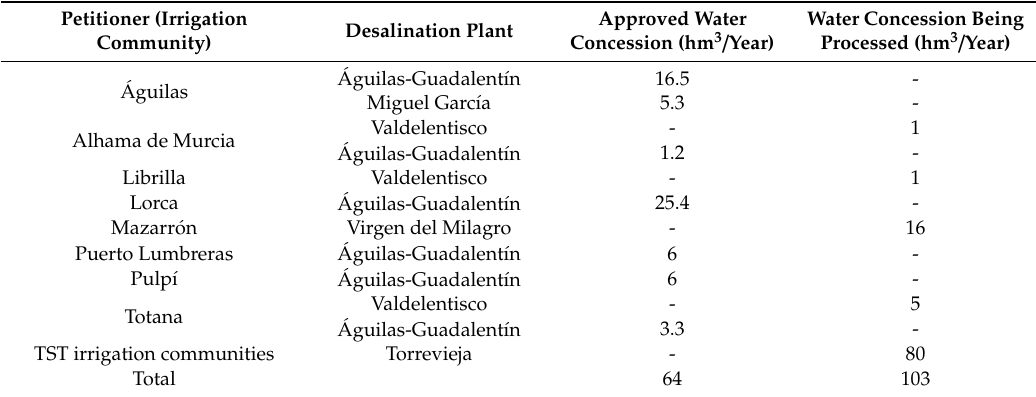
Table 2. Desalinated Water Concessions (approved and pending) of the irrigation communities surveyed by desalination plants at the end of